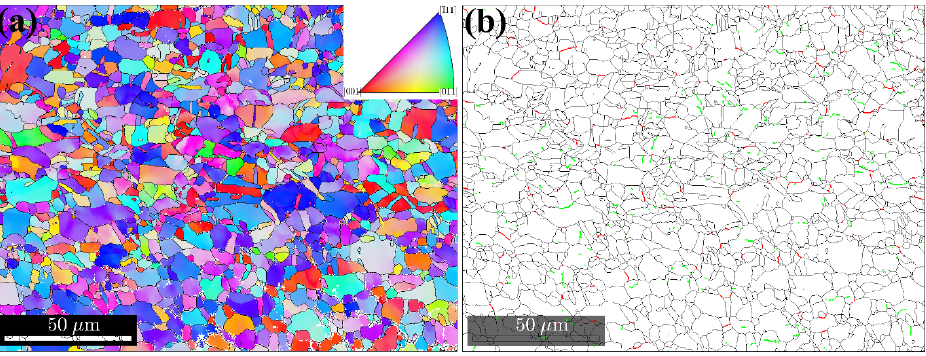
Figure 5. Figure 5. Cont.